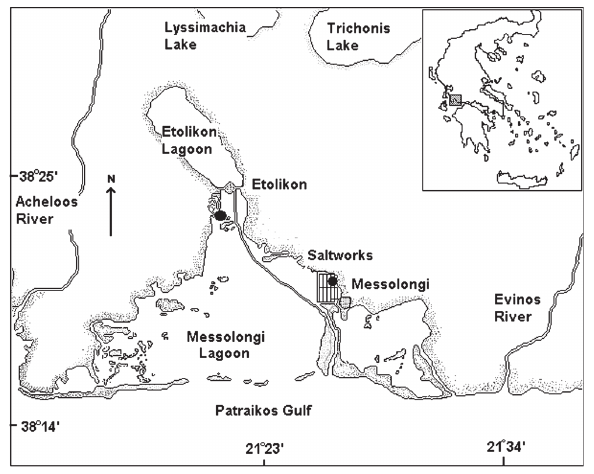
Fig . 1. – Map of the Messolongi Lagoon. The dots indicate the sam- pling